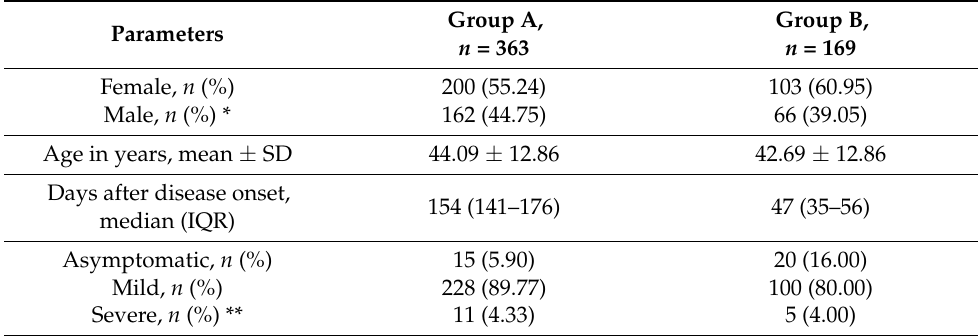
Table 2. Demographical and clinical characteristics of